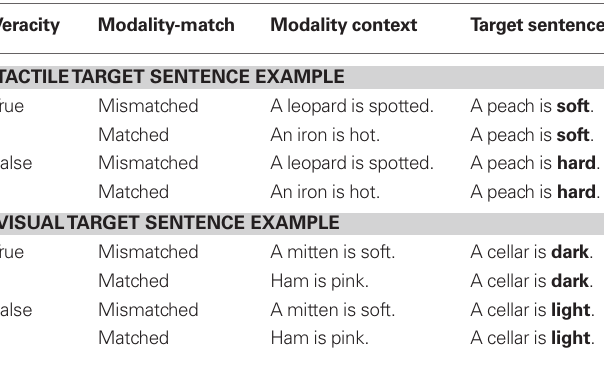
Table 1 | Example materials for tactile and visual